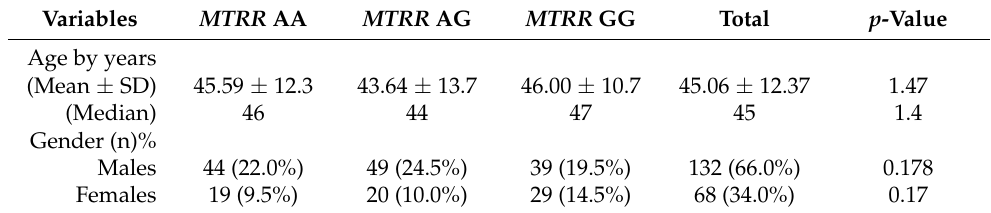
Table 1. Comparison of demographic data according to MTRR genotype among patients.